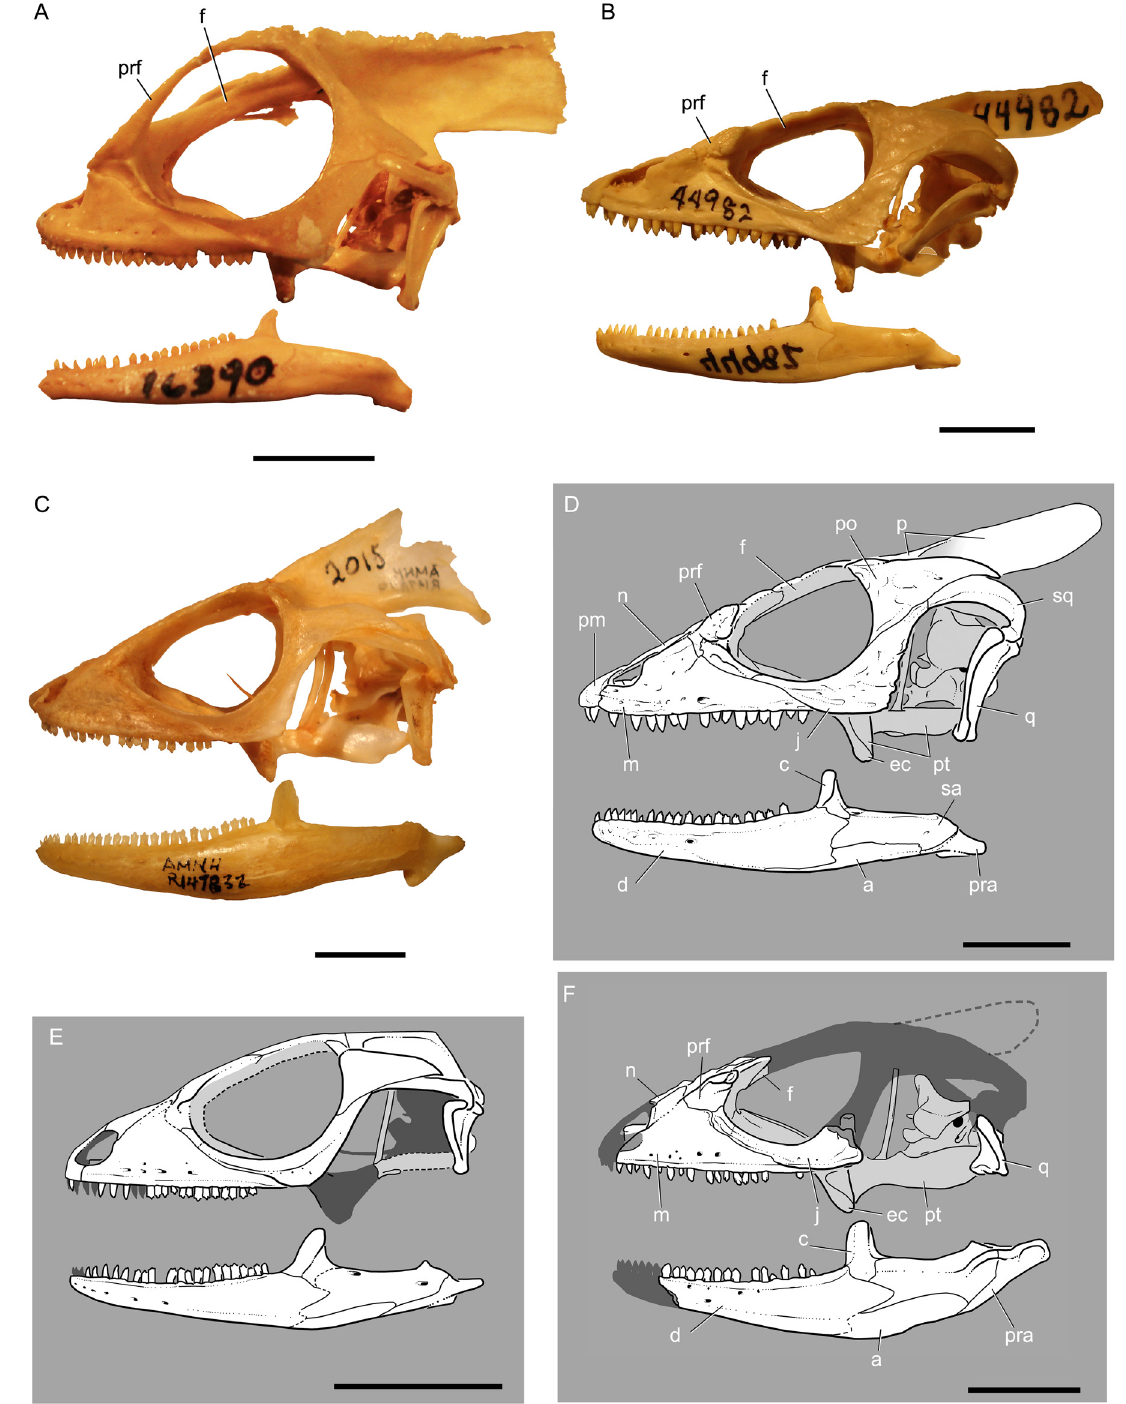
Fig 5. Photographs (A-C) and line drawings (D-F) of the skulls of selected corytophanid species in left lateral view. (A) Corytophanes cristatus (AMNH R 16390), (B) Laemanctus serratus (photograph; AMNH R 44982), (C) Basiliscus vittatus (AMNH R 147832), (D) Laemanctus serratus (line drawing), (E) Geiseltaliellus maarius , and (F) Babibasiliscus alxi taxon nov. (UWBM 89090). Note that it is unclear whether Babibasiliscus alxi taxon nov. had a parietal crest. Reconstructed areas are represented as semi-opaque areas and/or dotted lines. Scale bars equal 10mm.